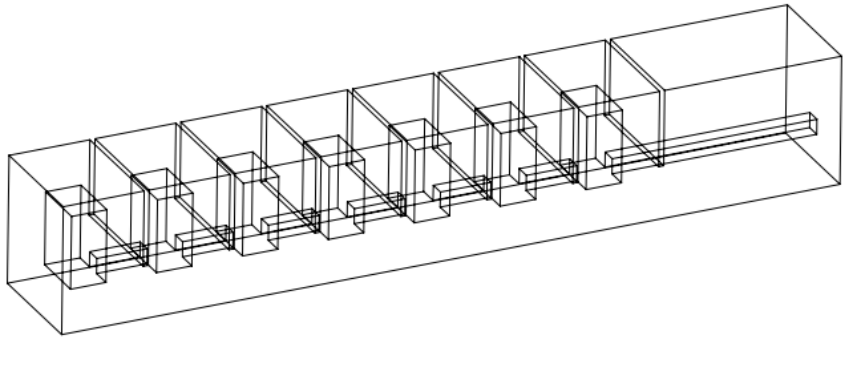
Figure 2. Diagram of multi-chamber pneumatic soft actuator’s inner and outer